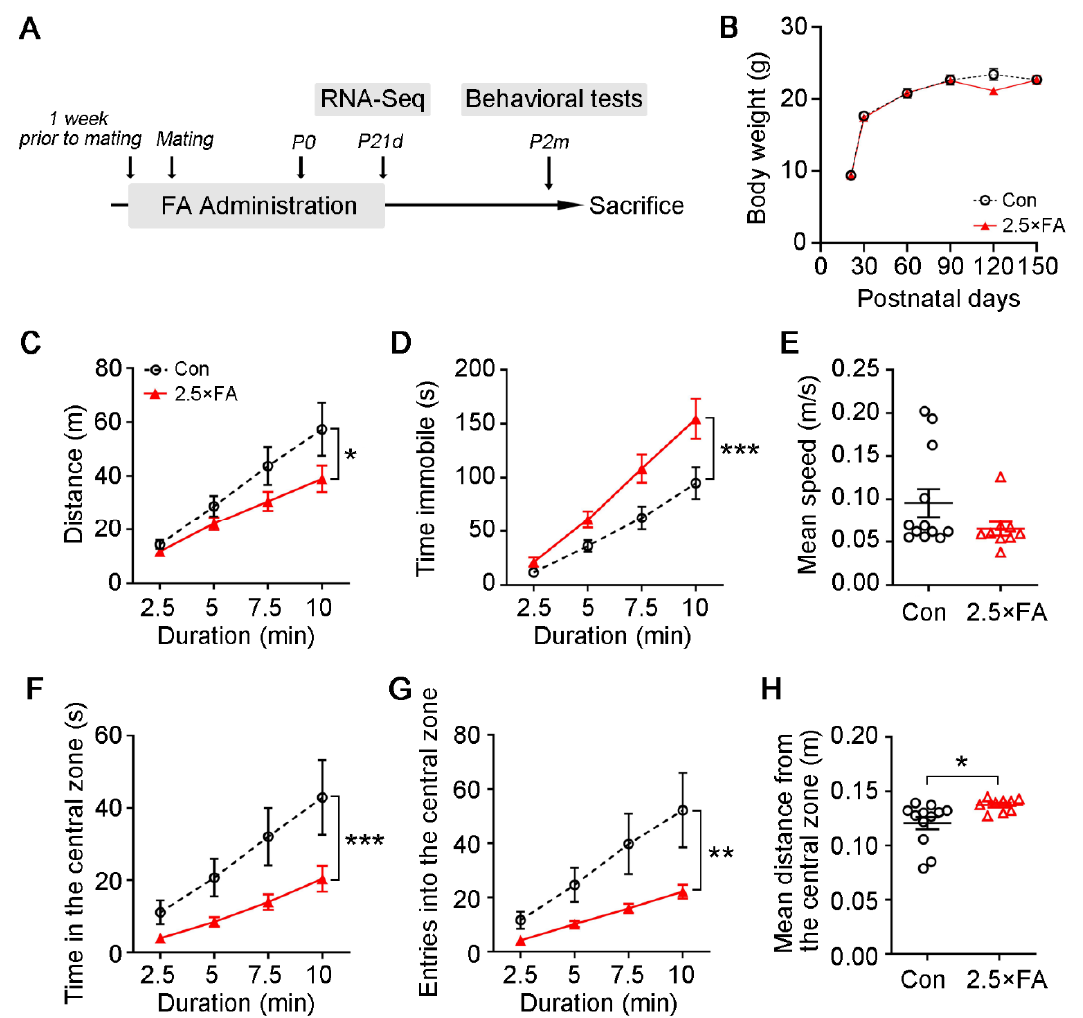
Figure 1. Effect of excess FA intake on body weight and the performance in open field test of the female offspring. ( A ) Schematic of the study design. ( B ) Control (Con) and 2.5 × FA female mice were weighed from postnatal day 21 to 150. ( C – H ) In the open field test, the distance traveled by the female offspring in the arena ( C ), the immobile time ( D ), the mean speed ( E ), the time spent in the central square ( F ), the numbers of entries into the central square ( G ) and the mean distance from the boundary of the central zone ( H ) were measured. Con, n = 12; 2.5 × FA, n = 9. *, p < 0.05; **, p < 0.01; ***, p < 0.001.